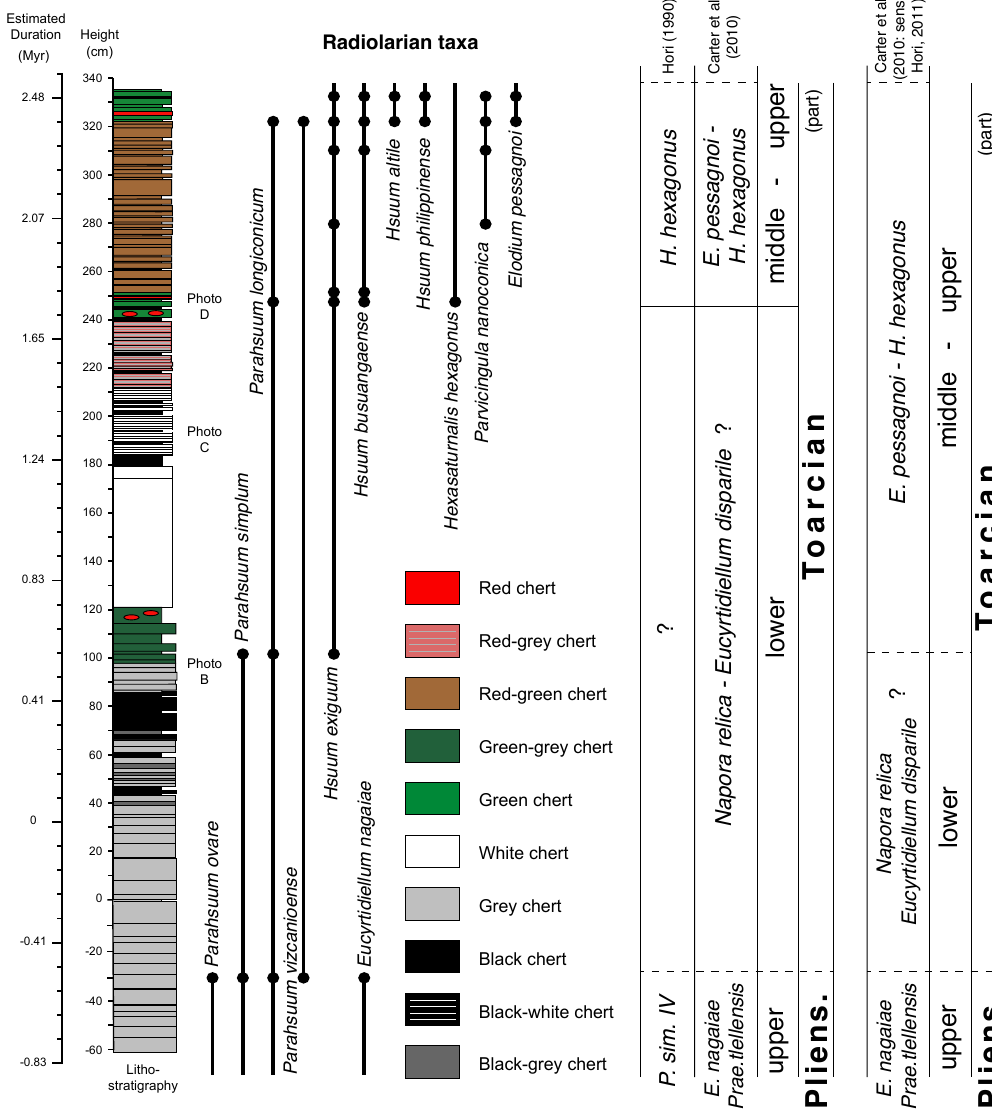
Fig. 4. Detailed lithostratigraphic log and biostratigraphy of the Katsuyama section, Inuyama, Japan. The stratigraphic positions of the photographs depicted in Fig. 3 are indicated beside the section. Radiolarian biostratigraphy is from Hori (1997) and modified according to Carter et al. (2010). There are two possible biostratigraphic zonation schemes used here: Carter et al. (2010) and Carter et al. (2010 sensu Hori, 2011, unpublished). See text for discussion. The major difference between these two zonations is based on the presence of only one species ( Hsuum exiguum ) to define to the middle Toarcian. On the basis of a 1mMyr − 1 sedimentation rate for the Lower Jurassic chert succession at Inuyama, the studied interval is calculated to be ca. 3.5Myr in duration (see Hori et al.,